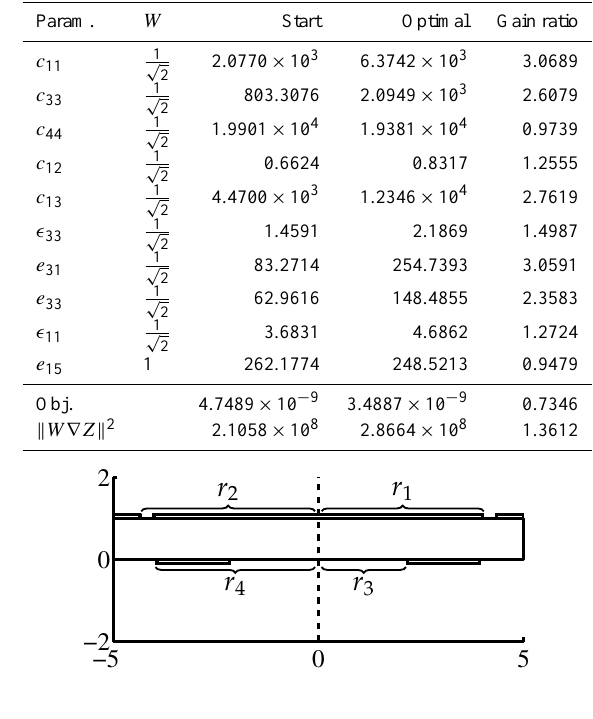
Table 3. Mixed weights: improvement of sensitivity of impedance w.r.t. material parameters using W = 1 √